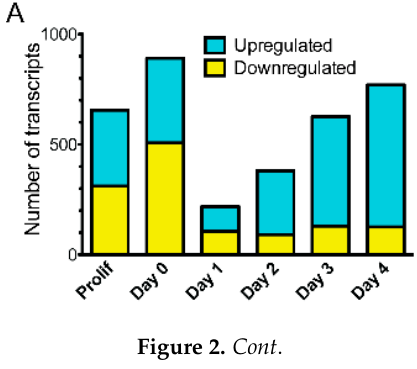
Figure 2. Cont. Figure 2. Cont.